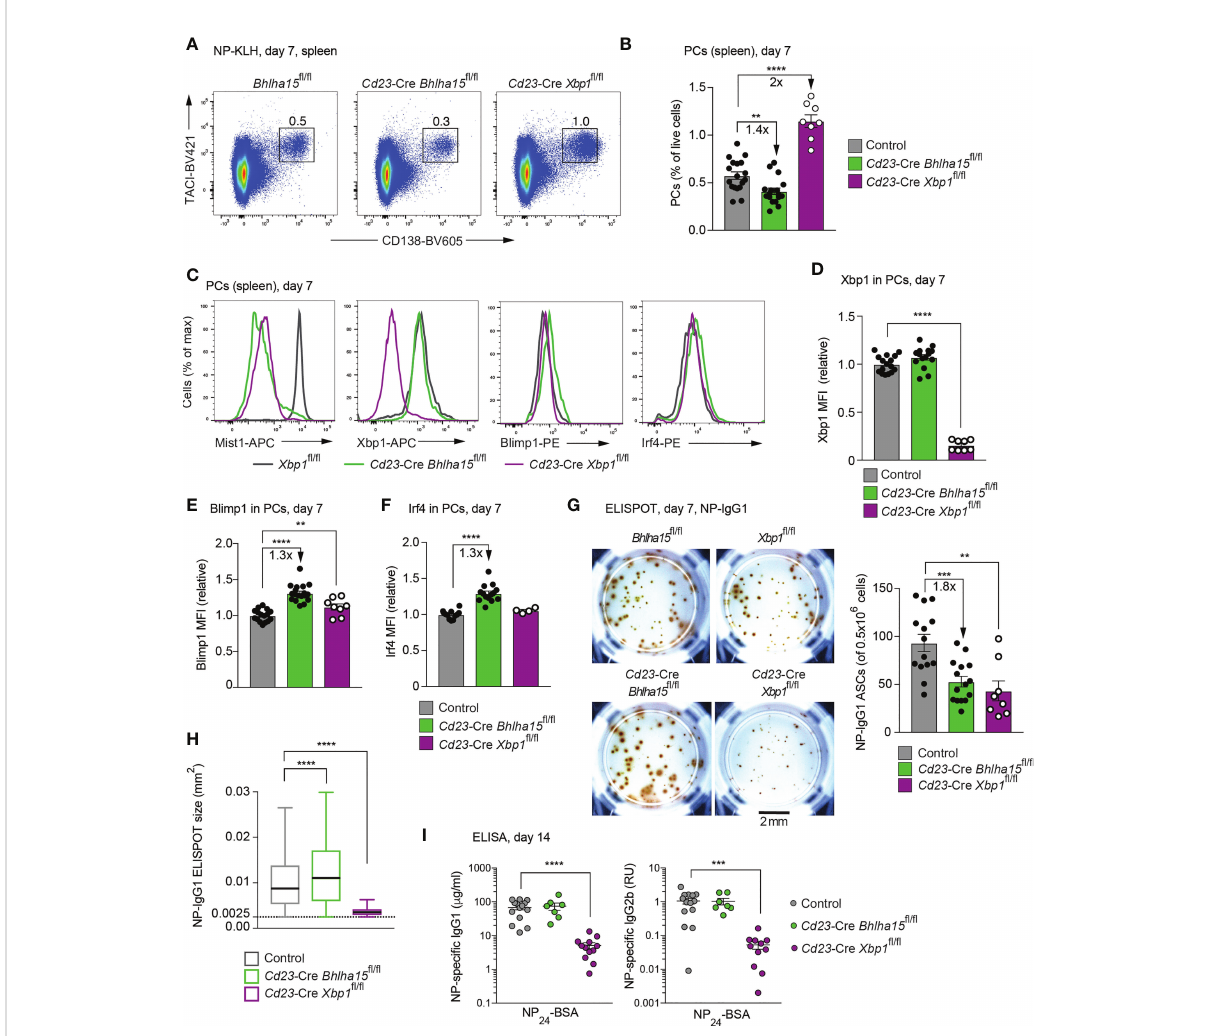
FIGURE 3 Reduced plasma cell numbers and increased antibody secretion in NP-KLH-immunized Cd23 -Cre Bhlha15 fl / fl mice. (A) Flow-cytometric analysis of PCs (TACI + CD138 + ) in the spleen of the indicated genotypes at day 7 after NP-KLH immunization (in alum). The percentage of cells in the indicated gate is shown. One of 2 ( Cd23 -Cre Xbp1 fl / fl ) or 3 ( Cd23 -Cre Bhlha15 fl / fl and control) independent experiments with similar results is displayed. (B) The relative frequency of PCs in the spleen of age-matched mice of the indicated genotypes at day 7 after NP-KLH immunization is shown for 2 or 3 independent experiments (see A ). Bhlha15 fl / fl and Xbp1 fl / fl mice served as controls. (C) Expression of Mist1, Xbp1, Blimp1 and Irf4 in splenic PCs from mice of the indicated genotypes, as determined by intracellular staining at day 7 after NP-KLH immunization. (D – F) Quanti fi cation of the mean fl uorescence intensity (MFI) of Xbp1 (D) , Blimp1 (E) and Irf4 (F) intracellular staining in PCs shown in (C) . The MFI values were normalized relative to those of the control mice (mean value set to 1). The results of 3 independent experiments are shown for the control and Cd23 -Cre Bhlha15 fl / fl genotypes and the results of 2 experiments are displayed for Cd23 -Cre Xbp1 fl / fl genotype. (G) ELISPOT analysis of NP-IgG1 ASCs from the spleen of the indicated genotypes at day 7 after NP-KLH immunization. Plates were coated with NP 24 -BSA and developed using anti-IgG1 antibodies. Left: Representative ELISPOT wells with the scale bar indicating 2 mm. Right: Quanti fi cation of the number of NP-IgG1 ASCs per 500,000 plated cells. The combined data of two experiments are shown. (H) Size distribution of the antibody- containing dots, which were produced by the NP-IgG1 ASCs shown in (G) . The dot sizes were automatically quanti fi ed by using the Fiji software (see Methods). Black lines indicate the median, and boxes represent the middle 50% of the data. Whiskers denote all values of the 1.5× interquartile range. Dots with a size of > 0.0025 mm 2 are analyzed. The results of one of 2 experiments are shown. (I) Serum titers of NP- speci fi c IgG1 or IgG2b antibodies at day 14 after NP-KLH immunization. Plates were coated with NP 24 -BSA and then developed with anti-IgG1 or anti-IgG2b. The NP-IgG1 concentration was determined relative to a NP-IgG1 standard (hybridoma line SSX2.1). RU; relative units. The data of 3 independent experiments are shown. Statistical data (B, D-I) are indicated as mean values with SEM and were analyzed with the unpaired Student ’ s t test (B, D – G, I) or Mann-Whitney test (H) ; ** P < 0.01; *** P < 0.001; ****, P < 0.0001. Each dot (B, D – G, I) represents one